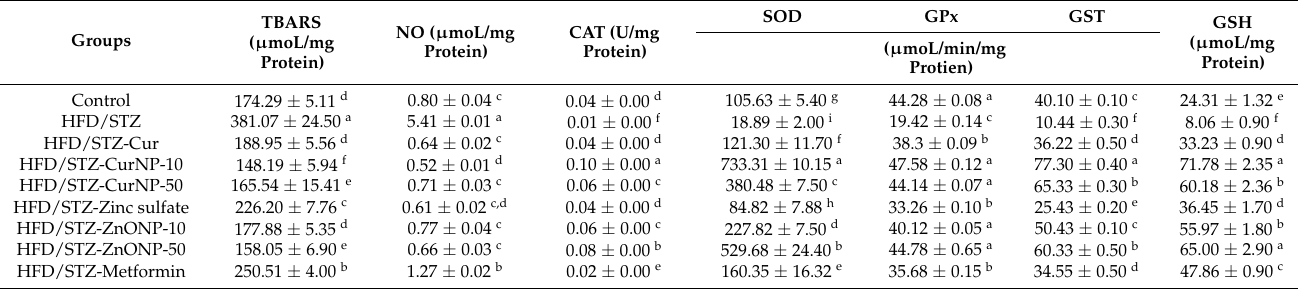
Table 2. Effect of CurNP and ZnONP on hippocampus oxidant and antioxidant biomarkers levels in HFD/STZ-induced and treated